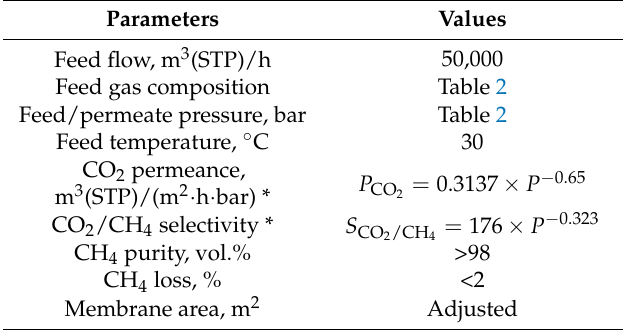
Table 1. The simulation basis for natural gas sweetening using carbon membrane system.